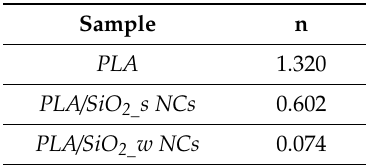
Table 1. Low-frequency slope of G’ versus ω